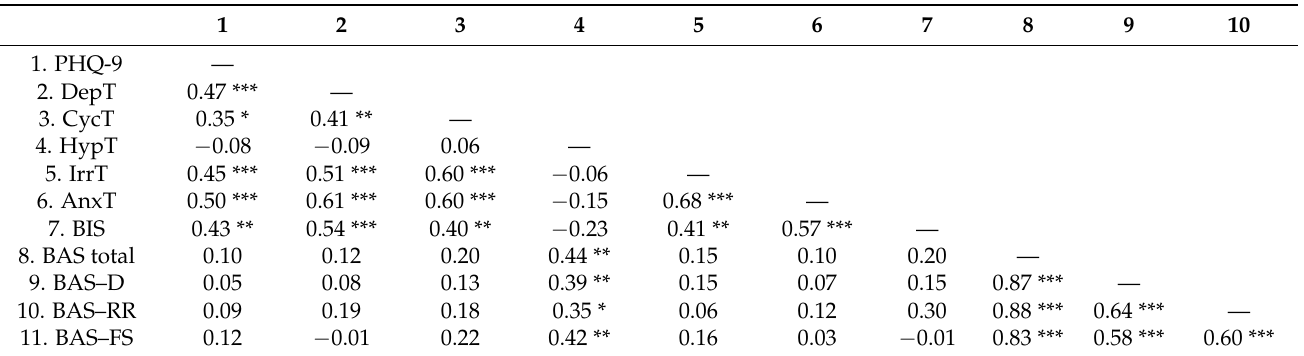
Table 2. Pearson’s correlation analysis ( N = 90).